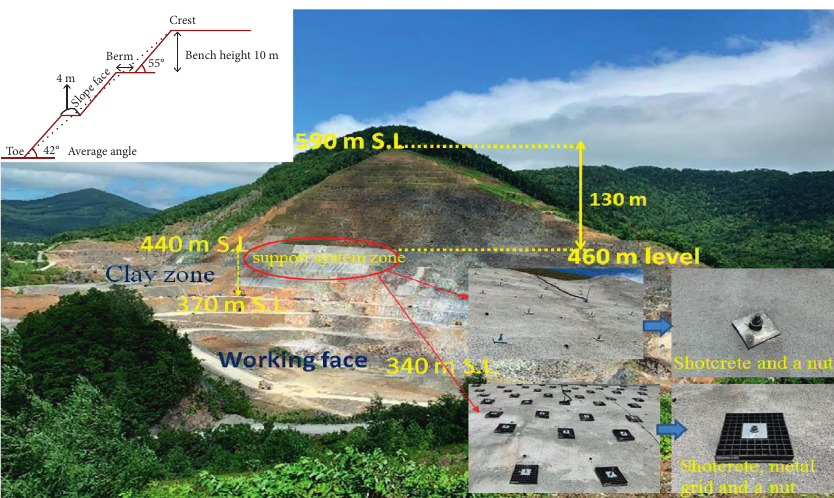
Figure 2: The layout of rock slope at the quarry (photo taken in the direction of yellow arrow shown in Figure 1). The support system zone is the area where rock bolts and shotcrete is installed to control the deformation.